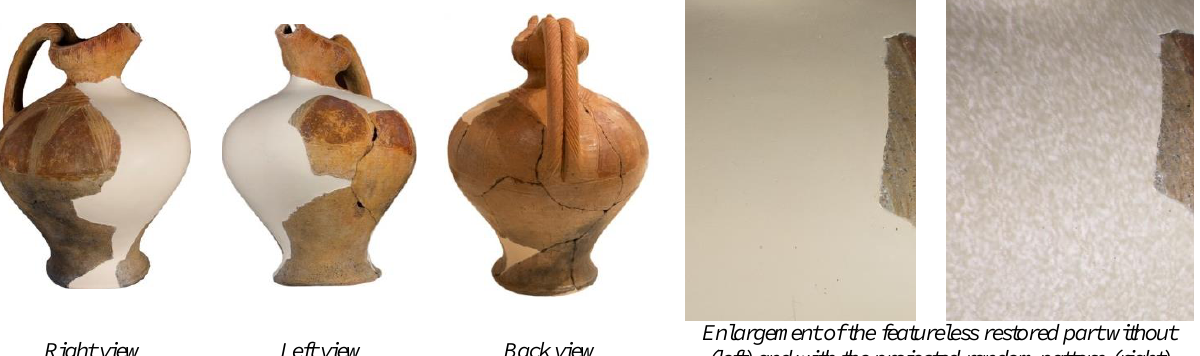
Figure 6. Ceramic jug (Collections of Castello del Buonconsiglio Museum, Trento, Italy).